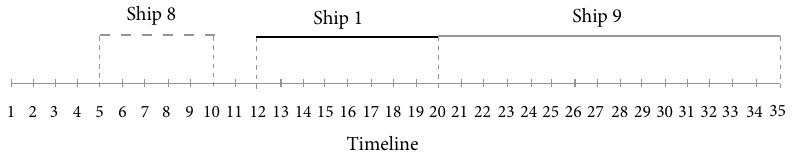
Fig. 4. Assignments of small ships to the small berth, obtained from one execution of RCGA